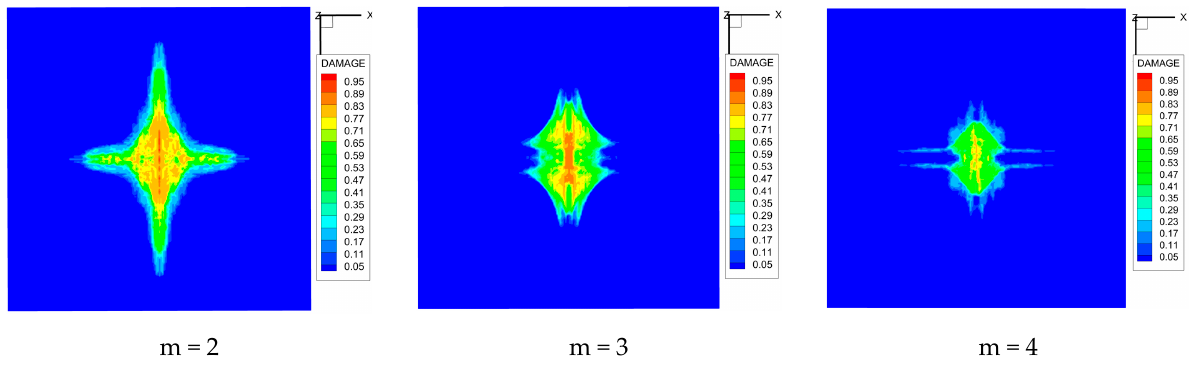
Figure 11. Damage pattern of composite laminate (rear surface).